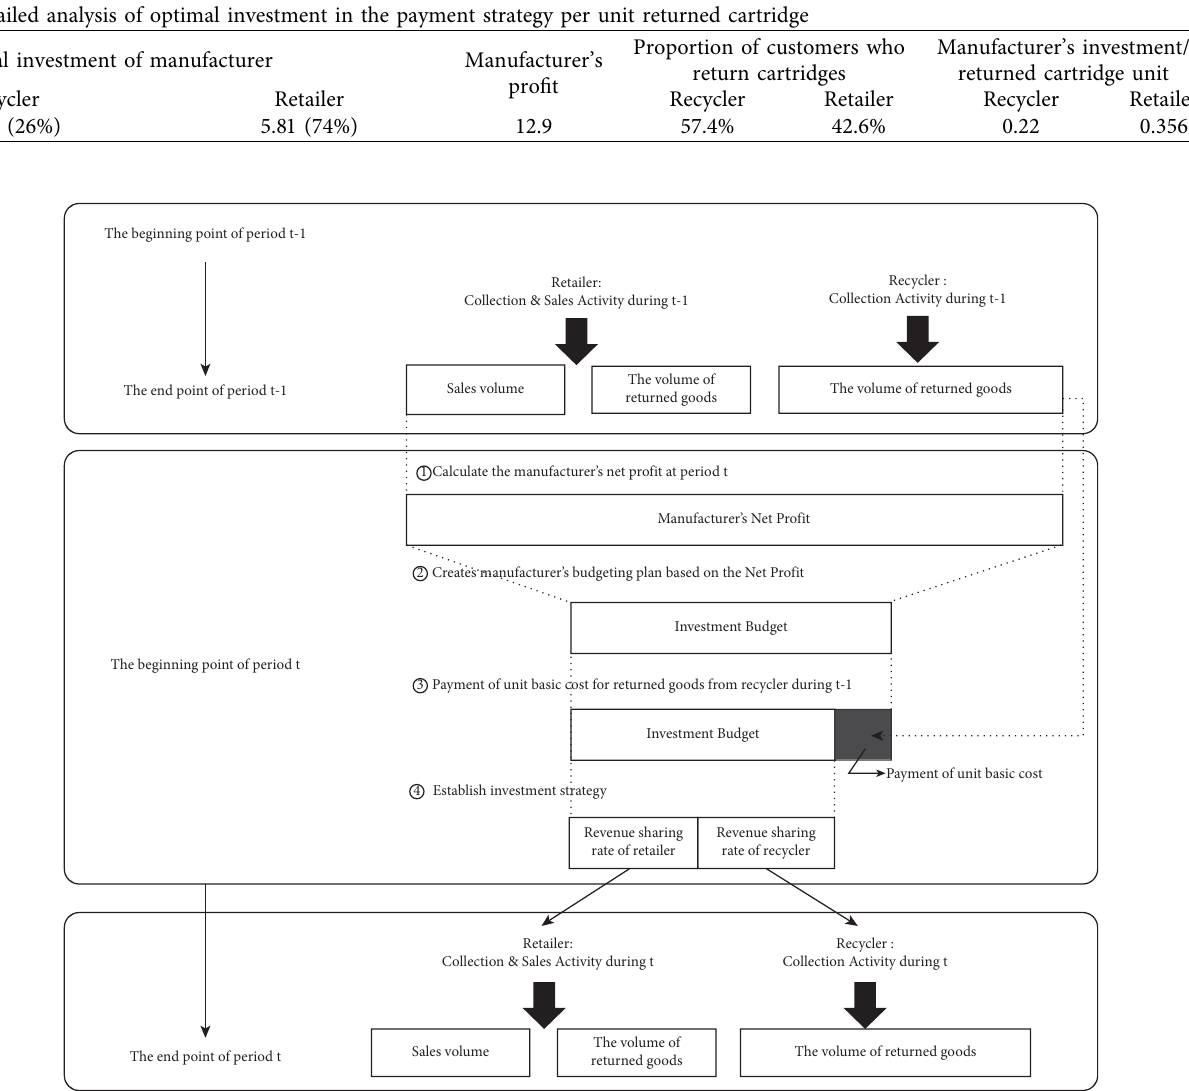
Figure 8: The procedure for the hybrid investment